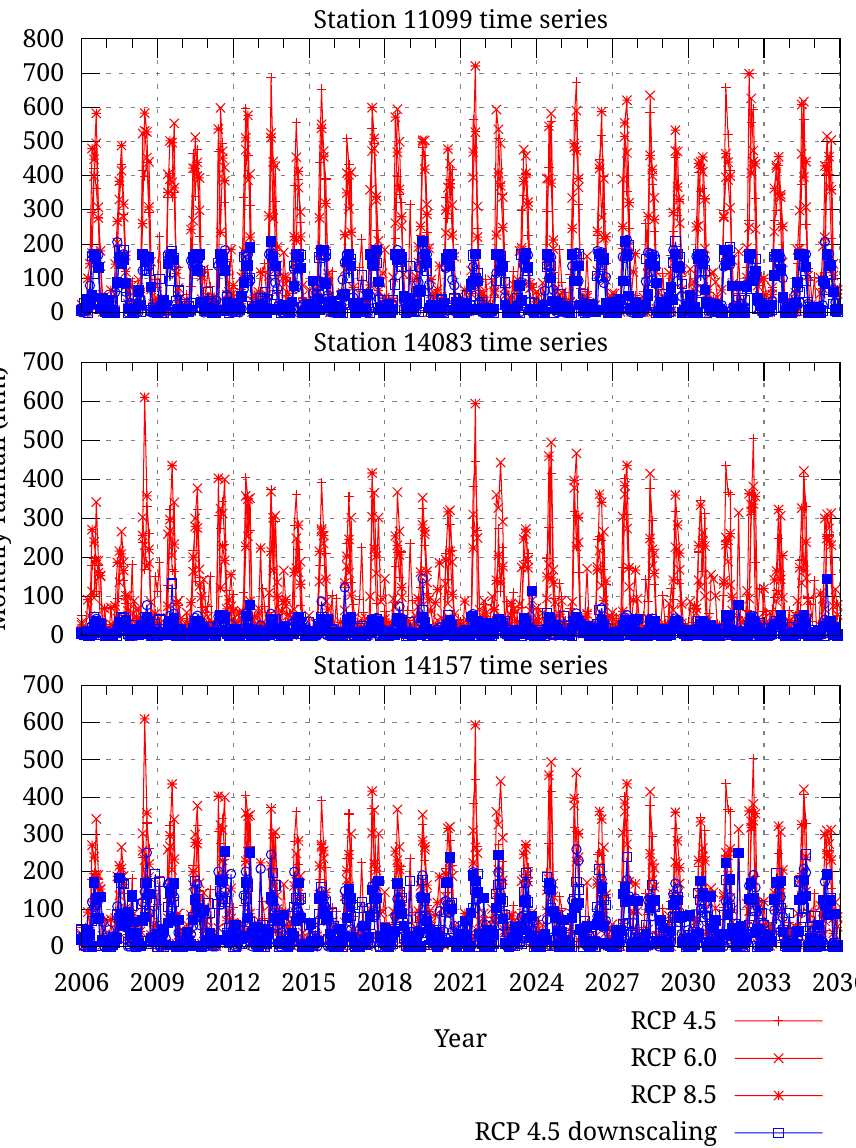
Figure 6. Projected precipitation using ANNs and the CSIRO-Mk3-6-0